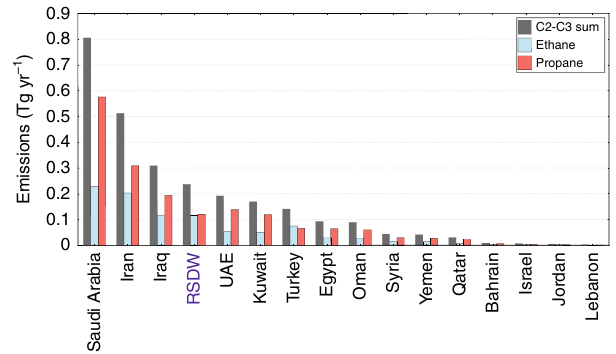
Fig. 4 Emissions of ethane and propane. The emissions from Middle Eastern countries compared with the emissions from the northern Red Sea Deep Water